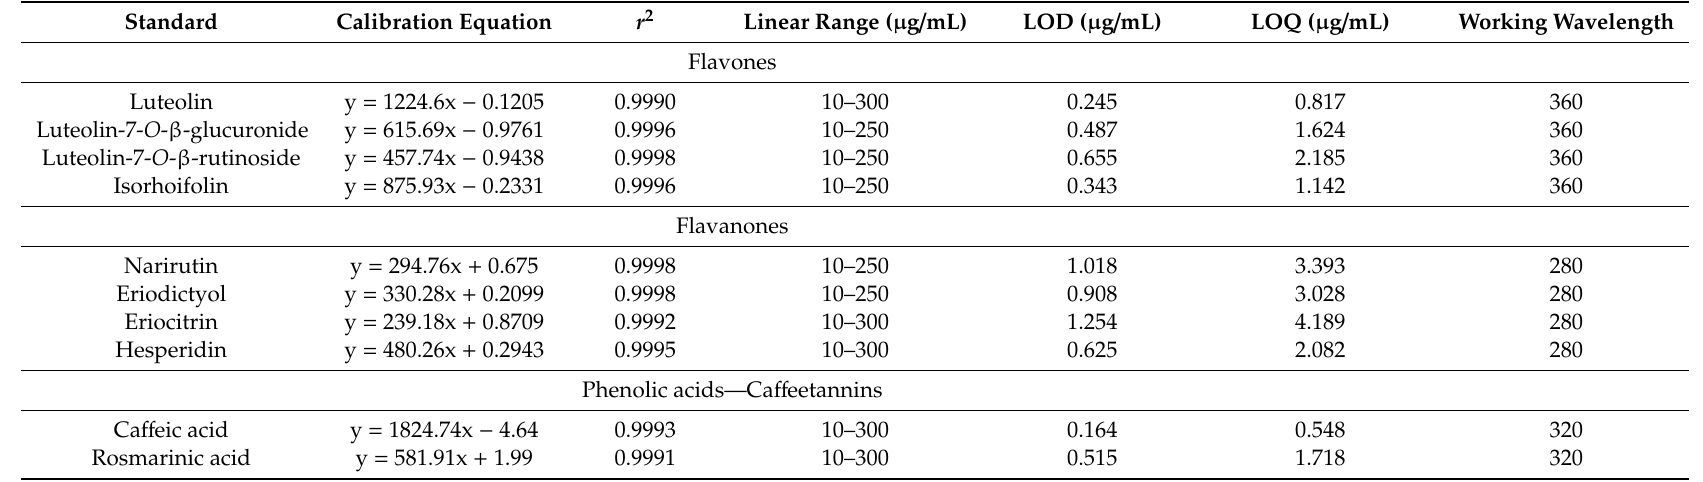
Table 3. Validation parameters of standard compounds for high performance liquid chromatography coupled with a diode-array detector (HPLC-DAD)